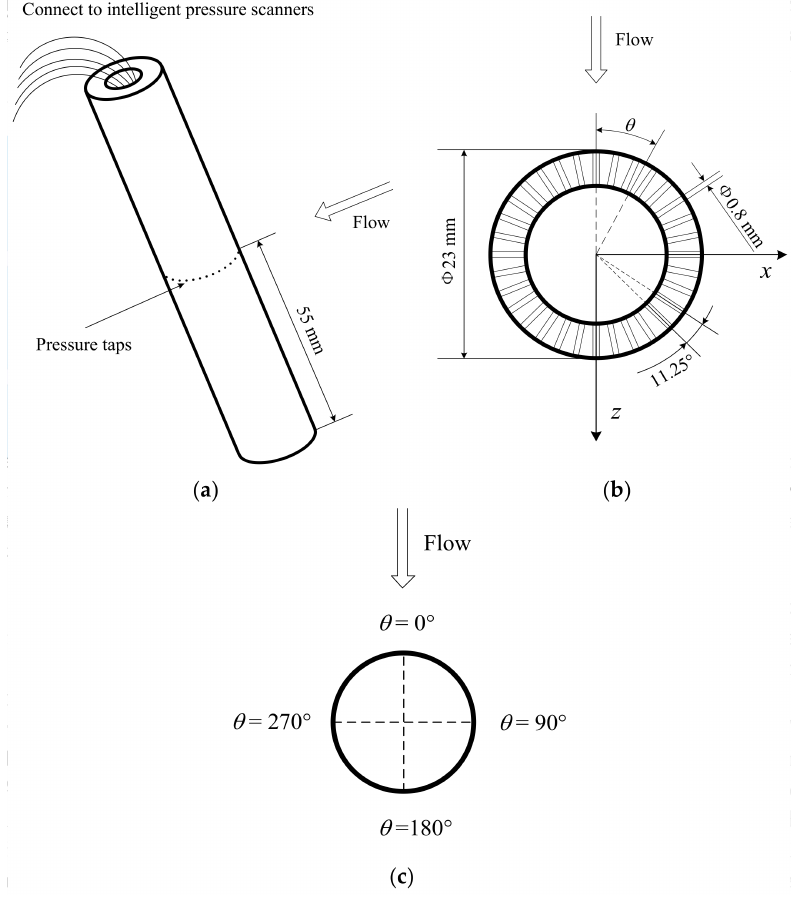
Figure 4. Details of the test cylinder and the angle around the cylinder surface: ( a ) the circular cylinder; ( b ) pressure taps; ( c ) angle around the circular cylinder